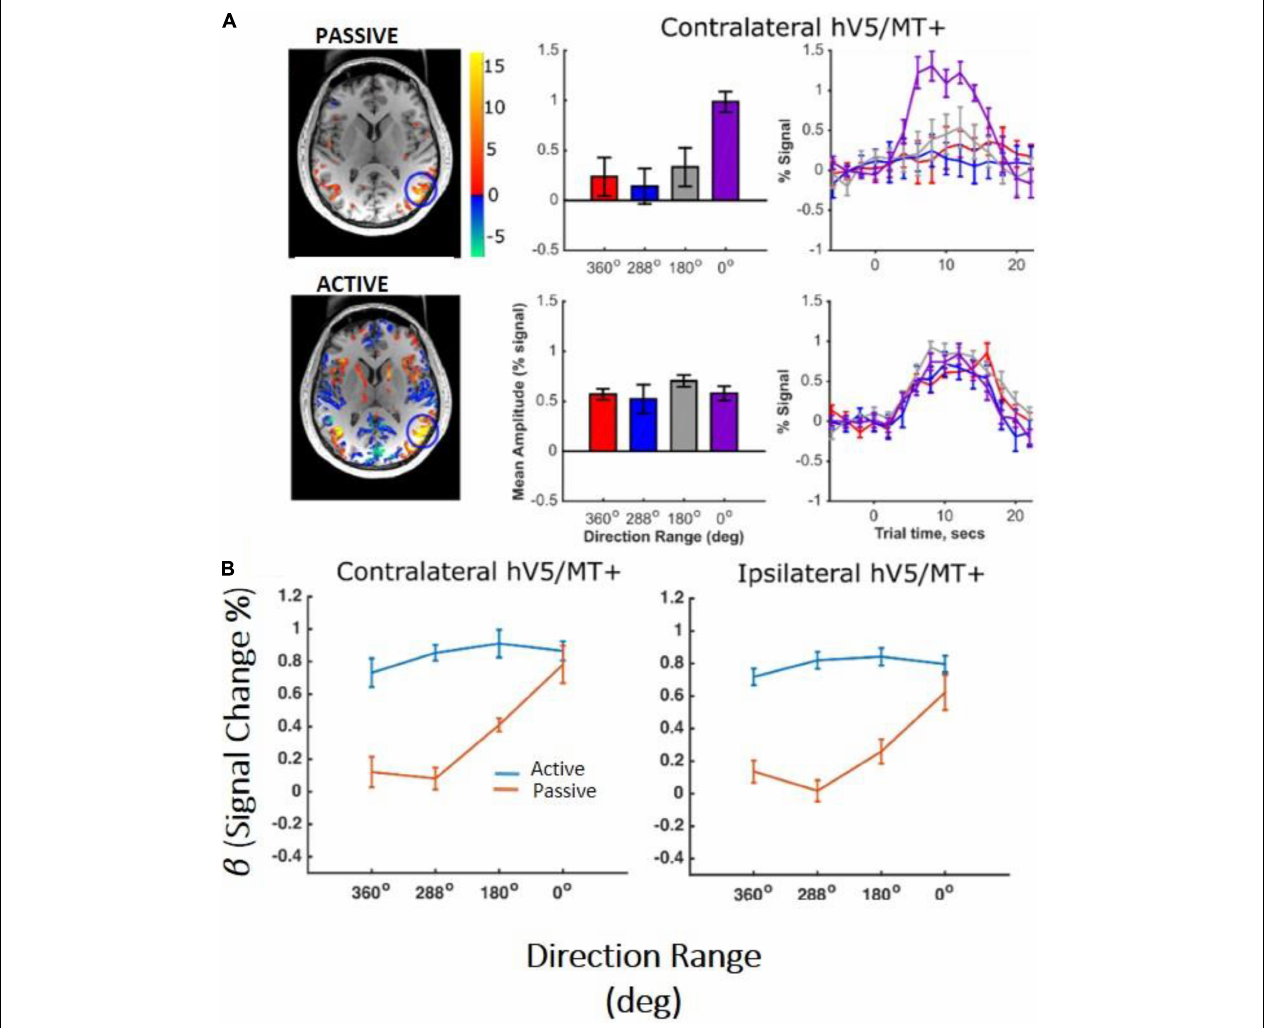
FIGURE 7 | hV5/MT+ responses to motion coherence in control subjects (study C). (A) Activation maps and average BOLD signal change in the contralateral hV5/MT+ of one subject, while the subject was performing an active direction of motion discrimination task (bottom) versus an unrelated task (passive) at fixation (top). For the passive condition, our results are consistent with our previous findings and the literature that BOLD signal modulation increases with coherence when no discrimination task is used. However, when the subject is performing direction of motion discrimination, the BOLD signal modulation is approximately the same at all coherences. (B) Average % BOLD signal change for all participants ( n = 6) performing the motion discrimination task (blue line) versus fixation (orange line). Error bars indicate the standard error of the mean across subjects. As in (A) , when the subjects are performing the direction of motion discrimination task, the BOLD signal modulation is approximately the same at all coherences. In contrast, when subjects are fixating without performing the motion discrimination task, BOLD signal modulation increases monotonically with coherence level. A similar activation pattern is also observed in ipsilateral hV5/MT+, presumably reflecting voxels that belong primarily to MST whose receptive fields are